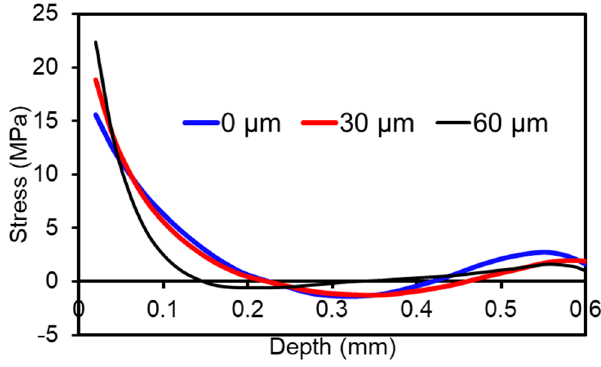
Figure 16. The effect of zero-depth setting on the residual